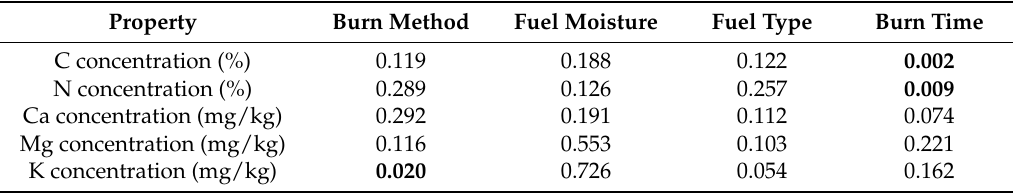
Table 5. Test results of analysis of variance for ash properties. Numbers represent the p -values and significant results were marked in bold fonts ( p <